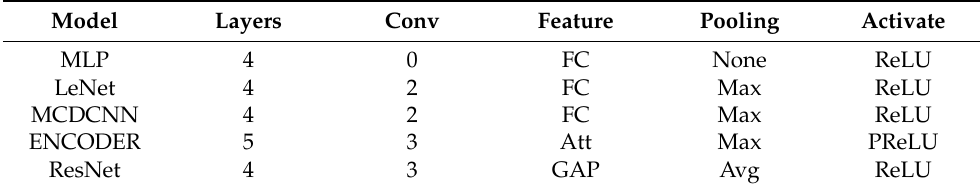
Table 2. Parameters of the five